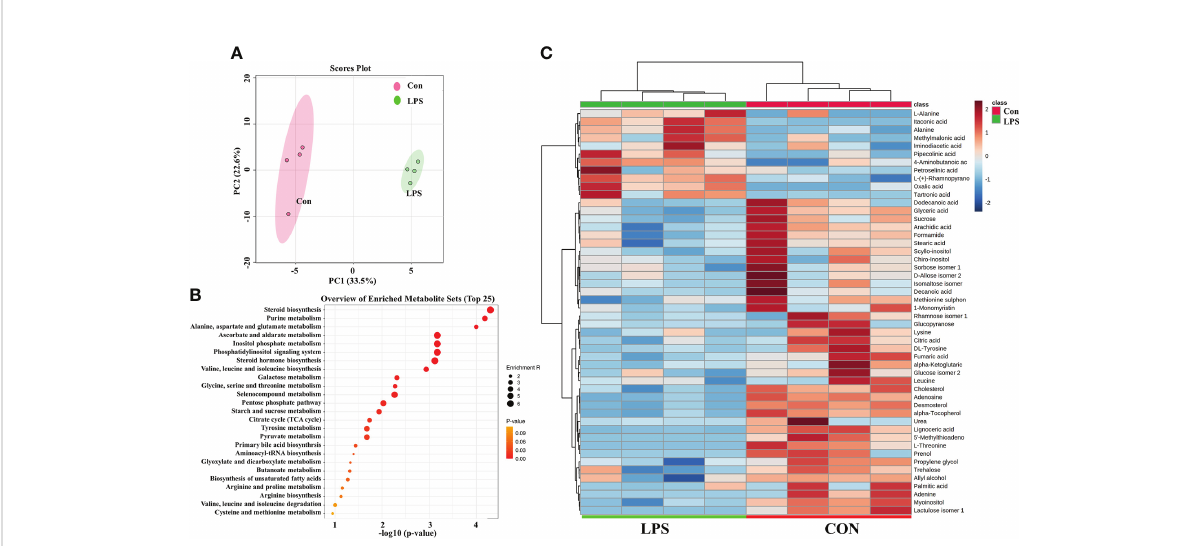
FIGURE 7 LPS affect the metabolism of liver cell line (NCTC-1469). (A) The principal components analysis (PCA) of two groups. (B) The metabolites enriched pathways (top 25) in PBS and LPS. (C) Heatmap of carbohydrate and lipid metabolites in PBS and LPS. N =